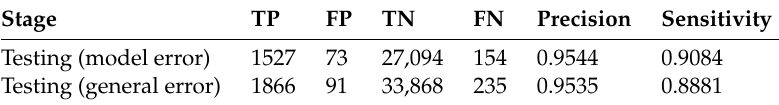
Table 6. Retraining Strategy III performance at learning rate 0.003.